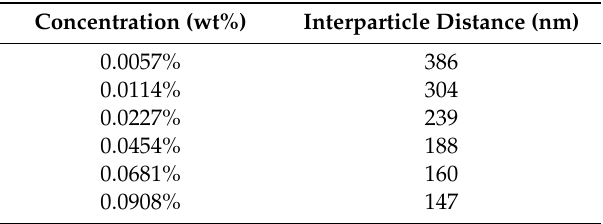
Table 1. Distance between nanoparticles in transformer